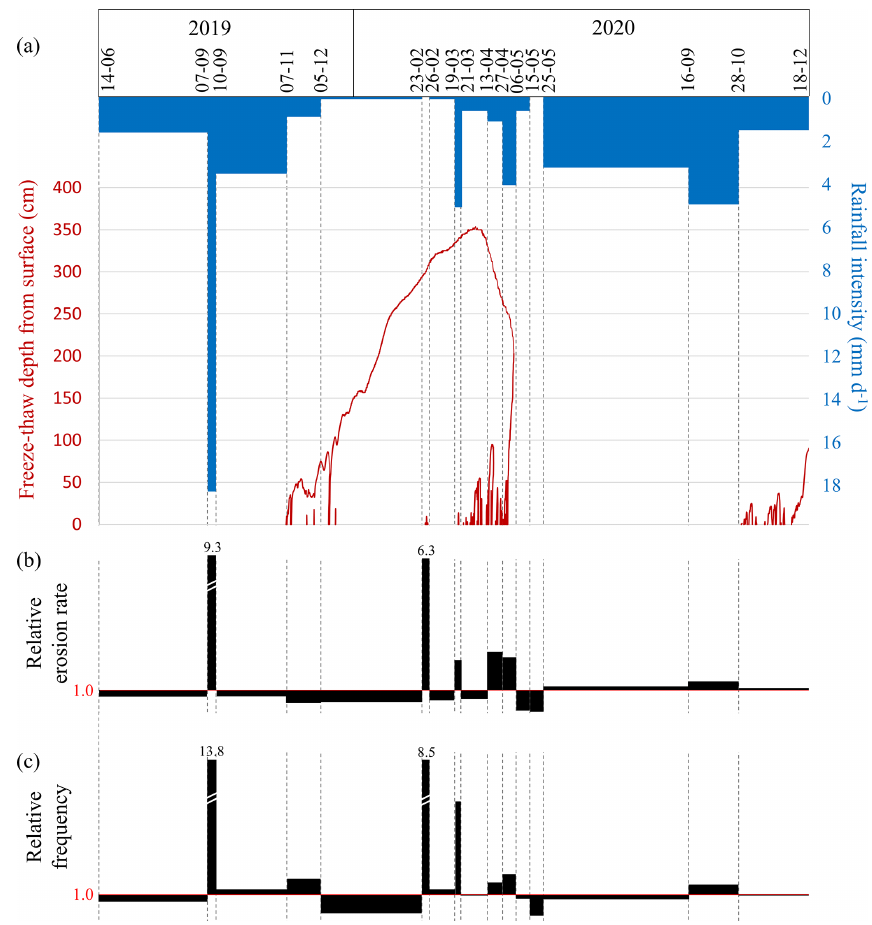
Figure 9. Main weather conditions (a) , erosion rates (b) and rockfall frequency (c) for each scanned survey period. Erosion rates and rockfall frequency are relative to mean erosion rates and mean rockfall frequency, respectively, between 14 June 2019 and 18 December